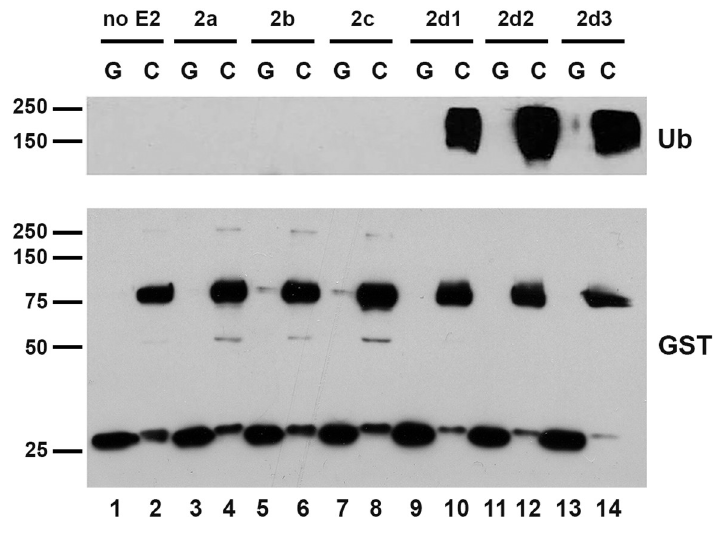
Fig 1. Ube2d family members mediate autoubiquitination of Cbl in vitro . In total 28 mammalian E2s were tested in an in vitro E3 assay for their ability to mediate autoubiquitination by GST-Cbl (aa 2–469) with activating Y371E mutation (C). A representative panel is showing that Ube2d1, Ube2d2 and Ube2d3 mediate autoubiquitination of Cbl while Ube2a, Ube2b, and Ube2c do not. GST (G) protein was used as a negative control. Reactions were immunoblotted and probed for ubiquitin (top panel). Parallel blots were probed for GST (bottom panel) demonstrating equal GST-Cbl and GST proteins loading. MW in kDa is shown to the left of the panels.